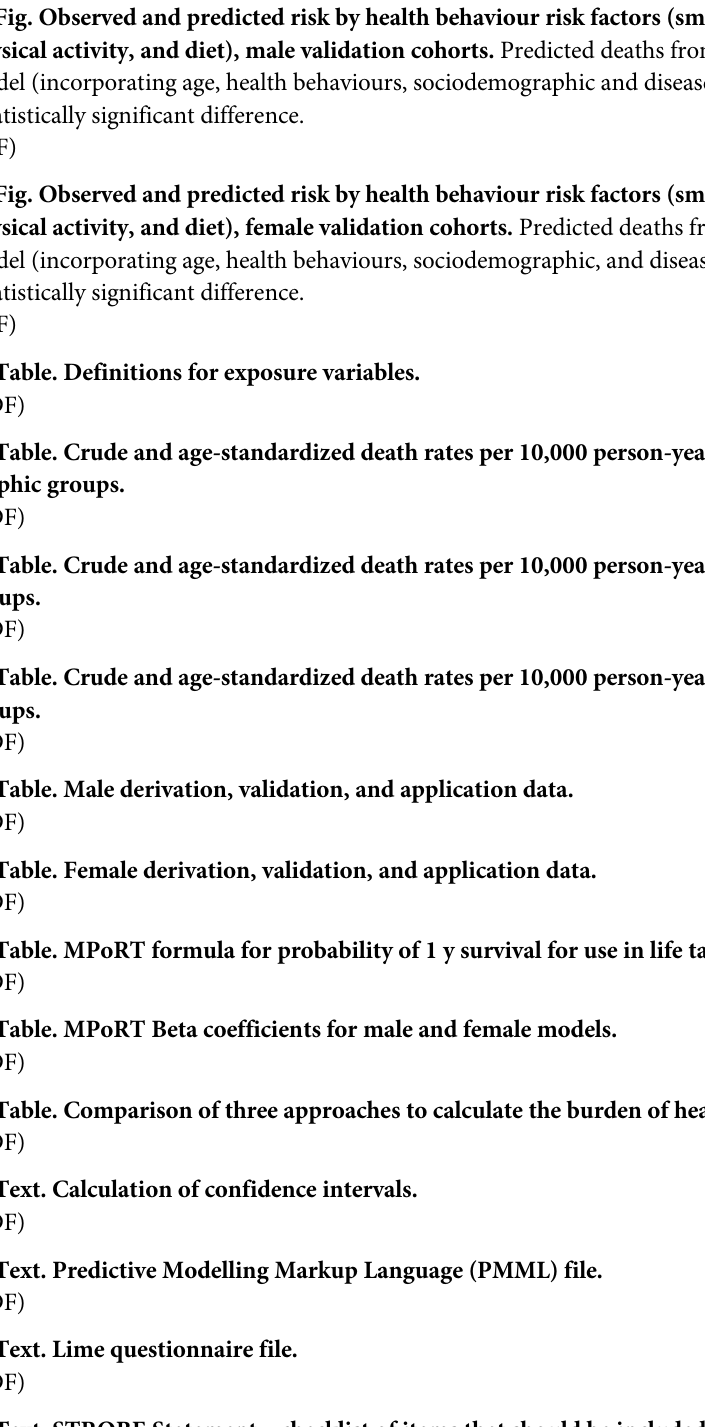
S3 Fig. Mortality hazards for physical activity, males, and females. S4 Fig. Observed and predicted risk by health behaviour risk factors (smoking, alcohol, physical activity, and diet), male validation cohorts. Predicted deaths from full MPoRT model (incorporating age, health behaviours, sociodemographic and disease indicators). (cid:3) Statistically significant difference. S5 Fig. Observed and predicted risk by health behaviour risk factors (smoking, alcohol, physical activity, and diet), female validation cohorts. Predicted deaths from full MPoRT model (incorporating age, health behaviours, sociodemographic, and disease indicators). (cid:3) Statistically significant difference. S1 Table. Definitions for exposure variables. S2 Table. Crude and age-standardized death rates per 10,000 person-years for sociodemo- graphic groups. S3 Table. Crude and age-standardized death rates per 10,000 person-years for disease groups. S4 Table. Crude and age-standardized death rates per 10,000 person-years for geographic groups. S5 Table. Male derivation, validation, and application data. S6 Table. Female derivation, validation, and application data. S7 Table. MPoRT formula for probability of 1 y survival for use in life tables. S8 Table. MPoRT Beta coefficients for male and female models. S9 Table. Comparison of three approaches to calculate the burden of health behaviours.